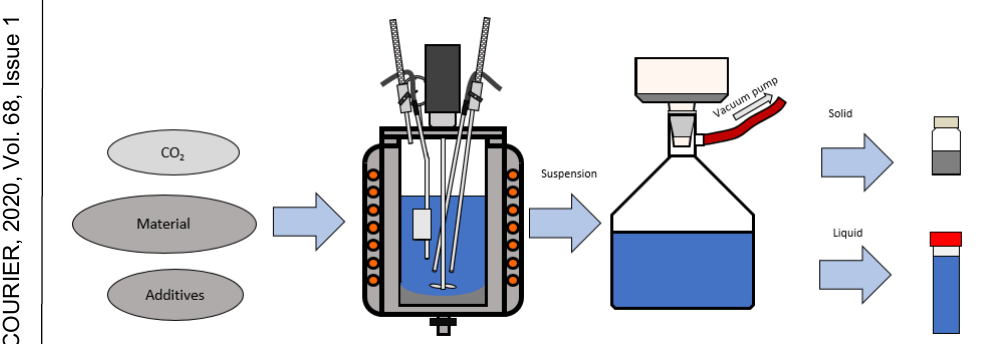
Figure 6 – Carbonation process of olivine and sampling